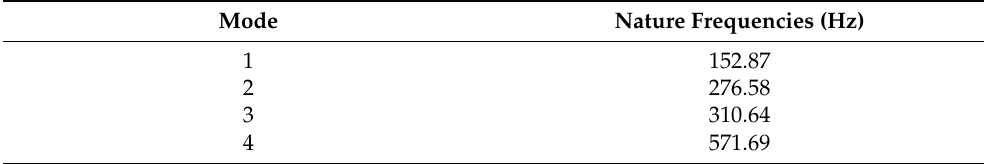
Figure 6. The first four mode shapes of the mechanism. ( a ) First mode, ( b ) 2nd mode, ( c ) 3rd mode, and ( d ) 4th mode. Table 2. First 4 modal frequencies of the